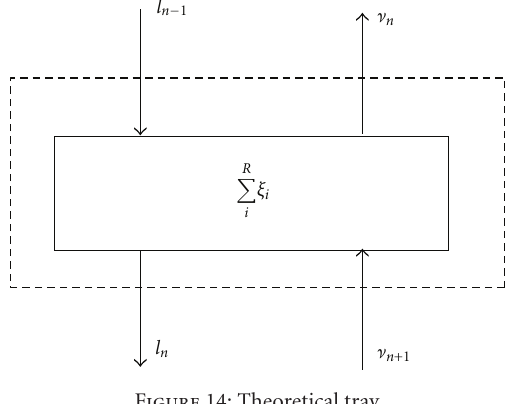
Figure 14: Theoretical